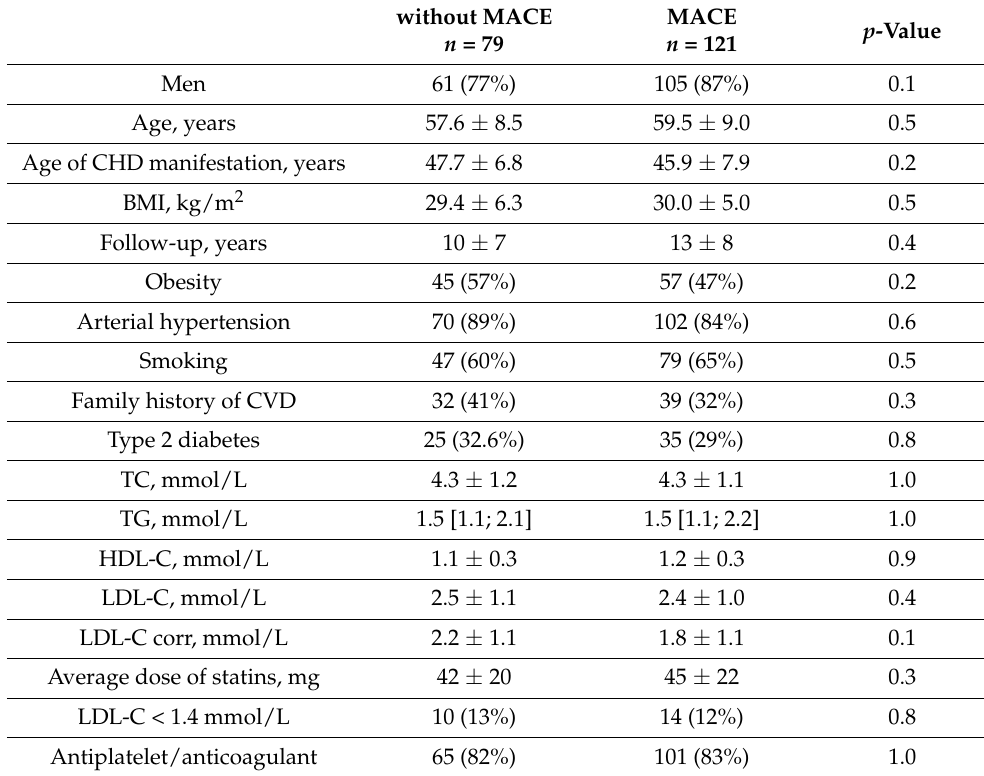
Table 1. The patients’ characteristics depending on the occurrence of MACE.